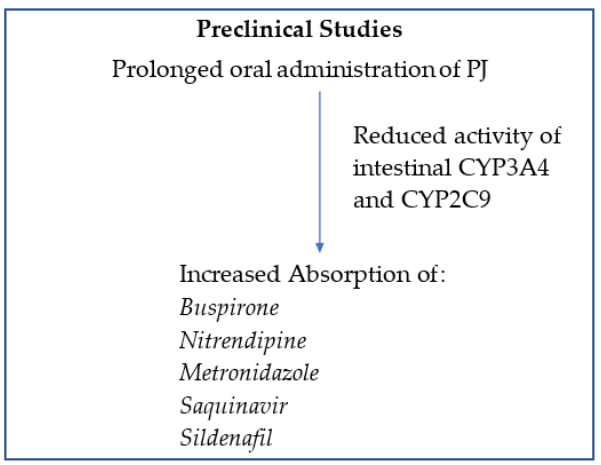
Figure 1. Schematic presentation of prolonged oral administration of PJ on the absorption of drugs metabolized by intestinal CYP3A4 and CYP2C9. metabolized by intestinal CYP3A4 and